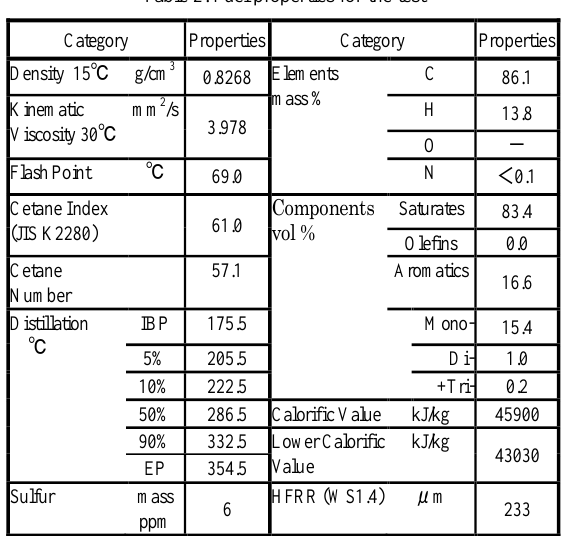
Table 2. Fuel properties for the